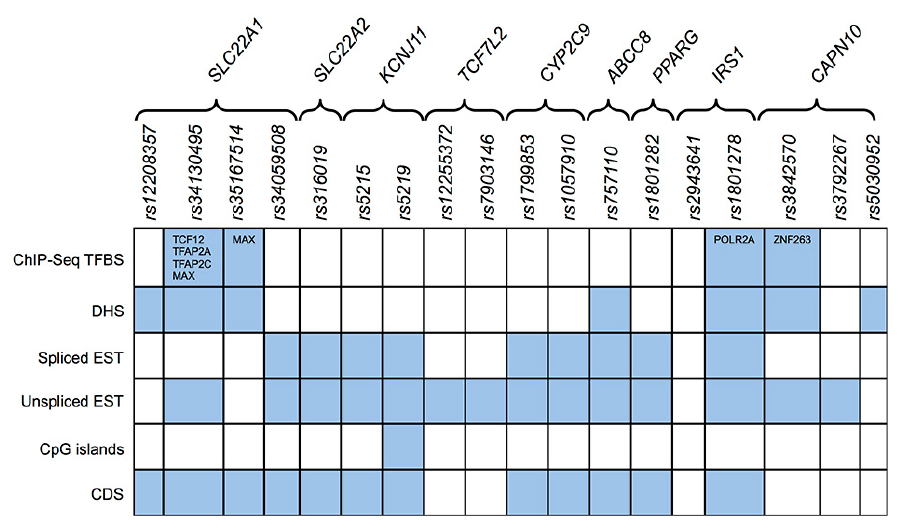
Figure 2. SNPs in drug resistance genes map to different regulatory regions. The panel shows a summary of the genomic regulatory elements that surround the SNPs herein analyzed. The cells in light blue indicate the presence of the SNP within a given regulatory element or genomic feature, whereas white cells indicate that the SNP does not fall within any of the analyzed regions. In the light blue cells of Transcription Factors Binding Sites detected by ChIP-Seq (ChIP-Seq TFBS row), the transcription factors are indicated that have binding sites potentially affected by the presence of the SNP (columns);. DHS (DNAse Hypersensitive Sites); EST (Expressed Sequence Tag); CDS (Coding Sequences).